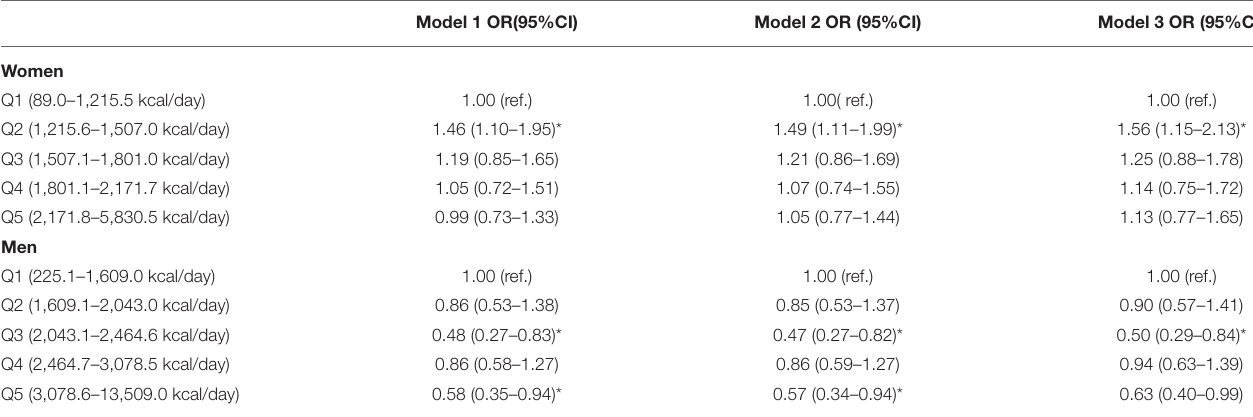
TABLE 2 | Weighted ORs and 95% CIs for constipation among men and women according to the quintiles of dietary energy intake. Model 1 OR(95%CI) Model 2 OR (95%CI) Model 3 OR